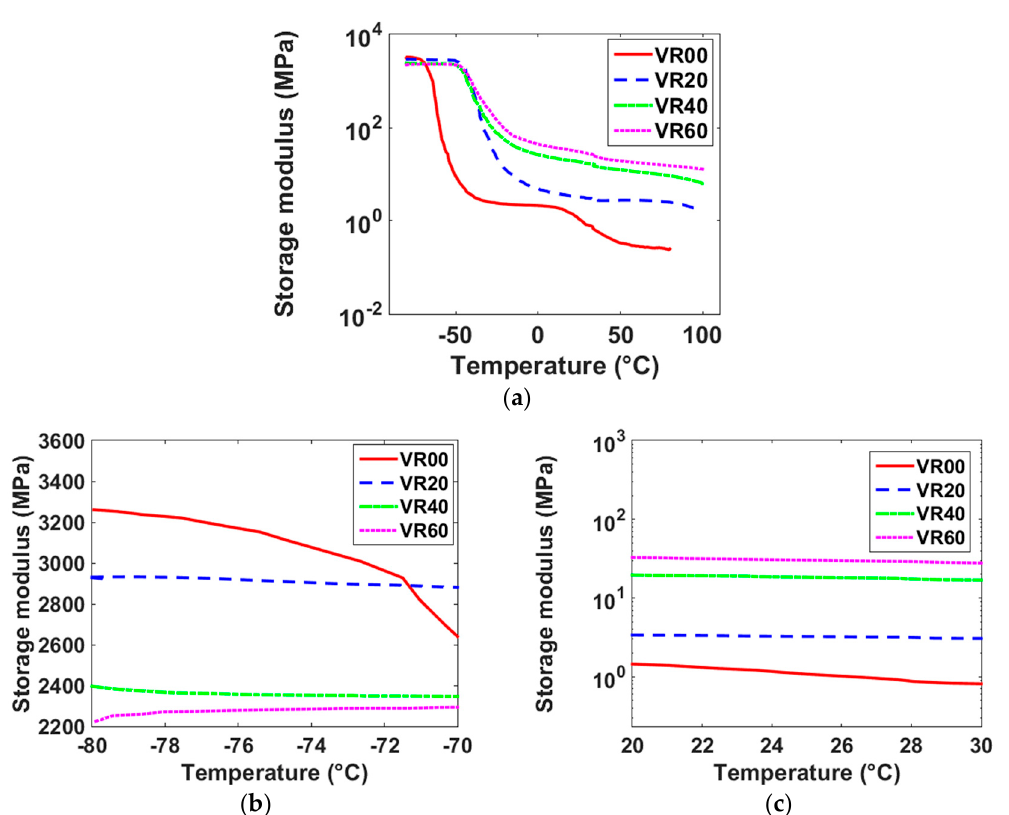
Figure 2. Storage modulus vs. temperature curves for the four vulcanizates ( a ) ranging from − 80 °C to 100 °C, ( b ) glassy region for all four materials as observed from − 80 °C to − 70 °C, and ( c ) rubbery region for all four materials as observed from 20 °C to 30 °C.